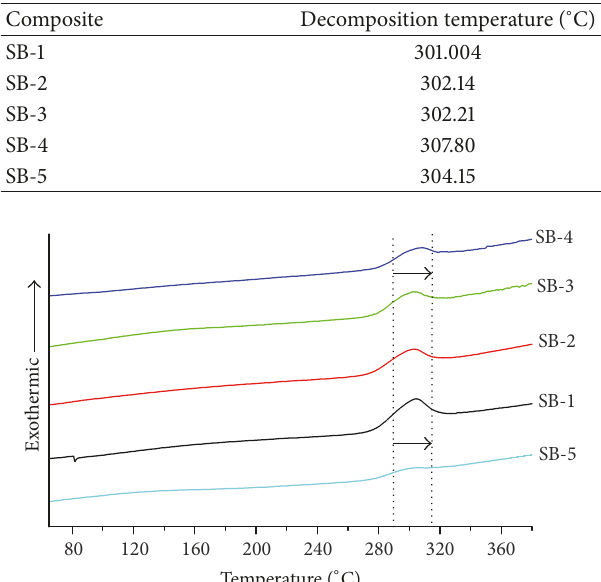
Table 3: The decomposition temperature of the composites.